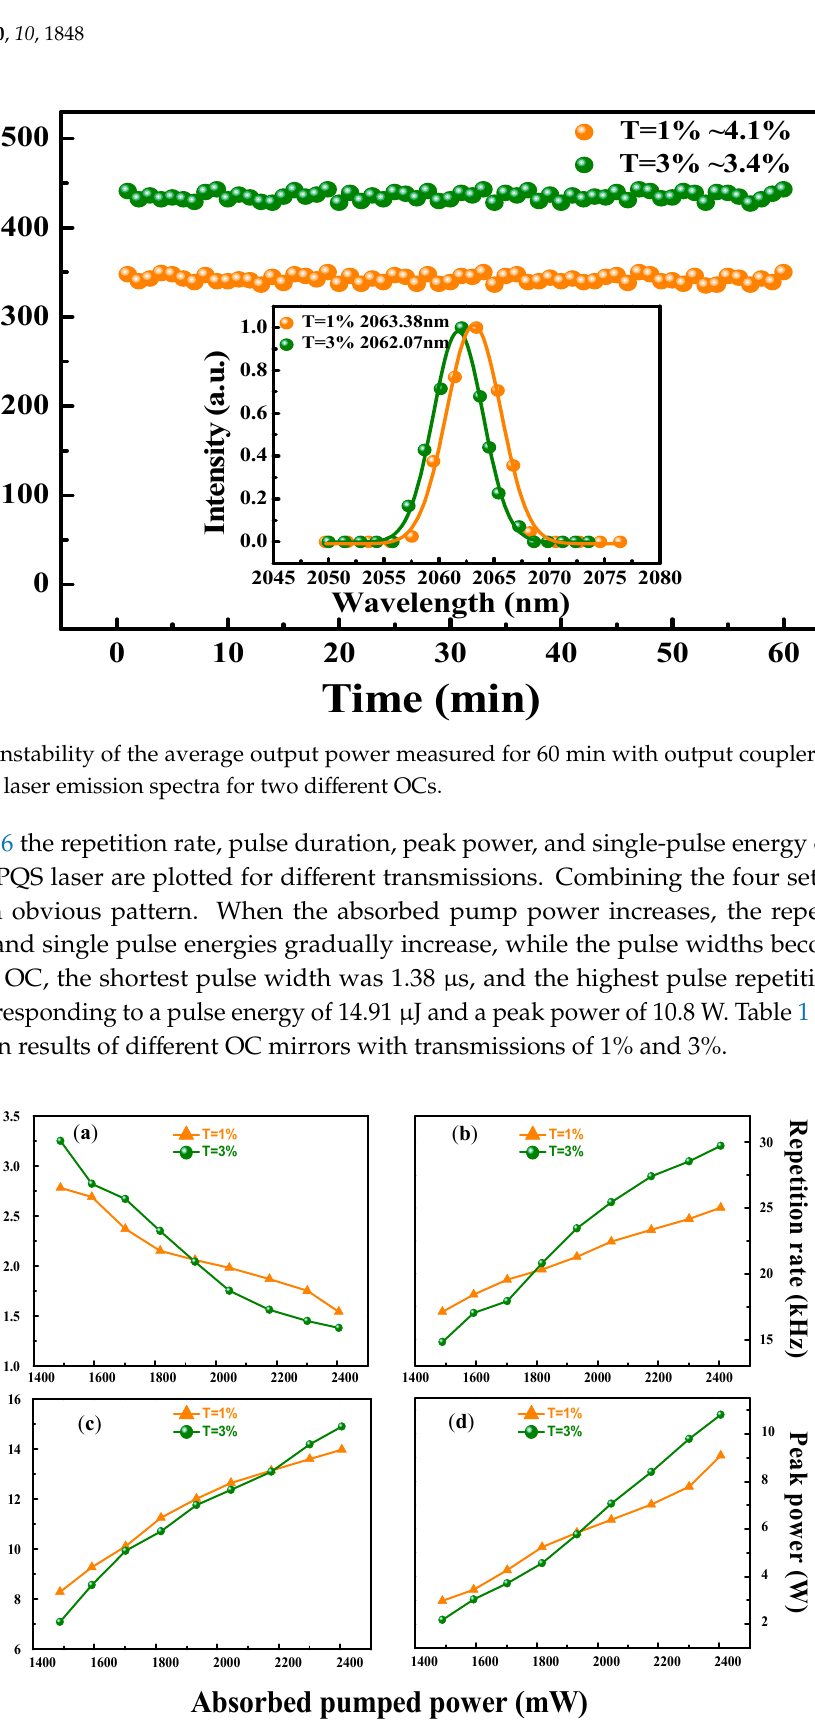
Figure 6. ( a ) Pulse widths, ( b ) repetition rates, ( c ) single pulse energies, and ( d ) peak powers as functions of the absorbed pump power.